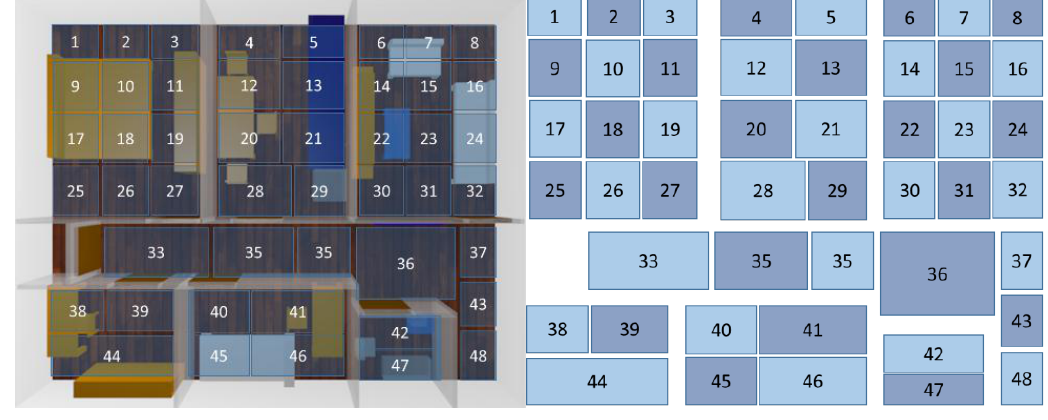
Figure 16. Grid distribution of the flat. Table 3. Performance evaluation of the Location system.